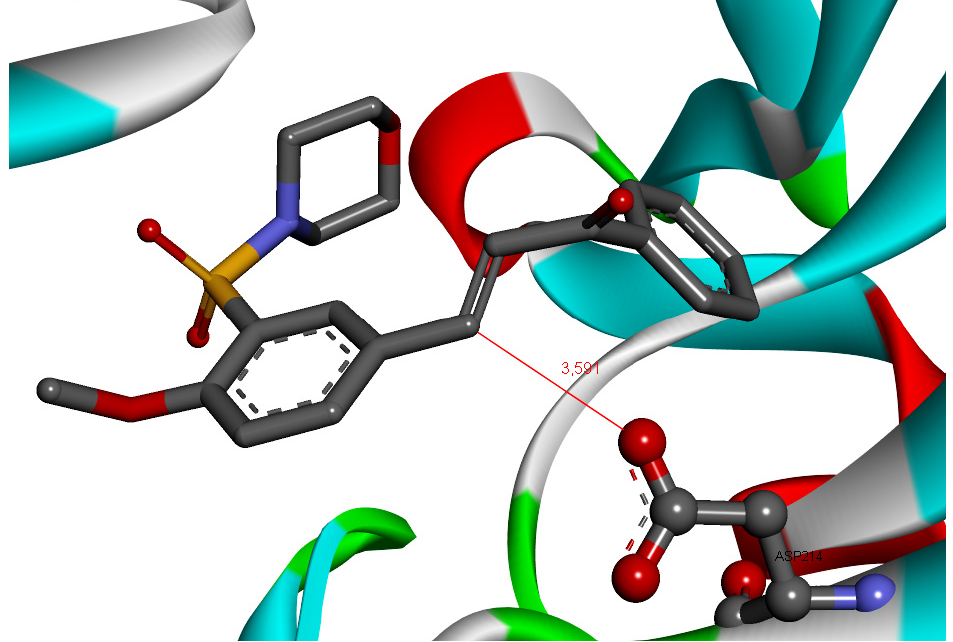
Figure 5. Compound 1a docked into the plasmepsin-2 (PL-2) binding site. Highlighting the the α , β -unsaturated carbonyl moiety (Michael acceptor) and carboxylate anion (Michael donor) of